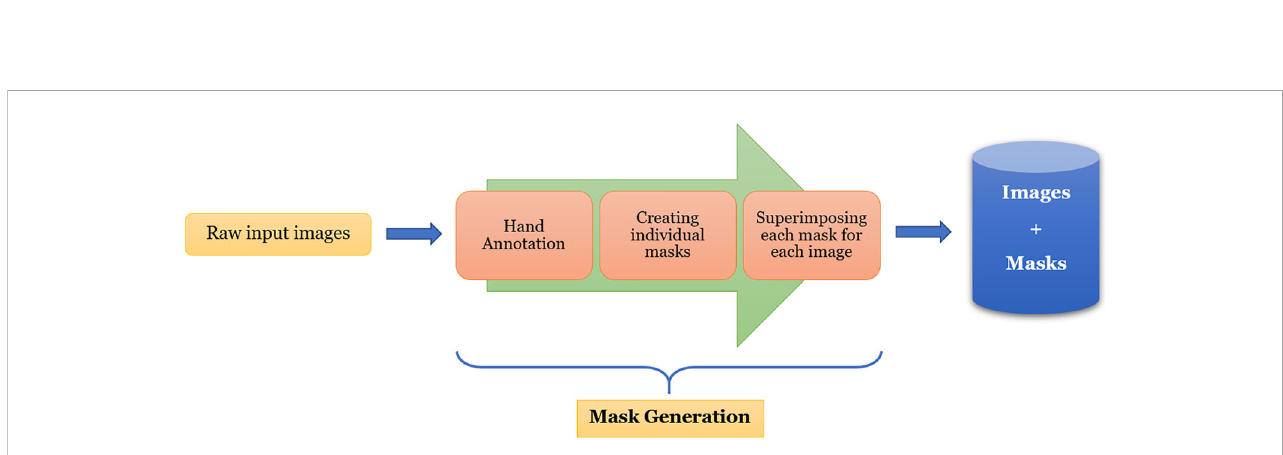
FIGURE 2 Illustration of mask generation process for UNL-MED.